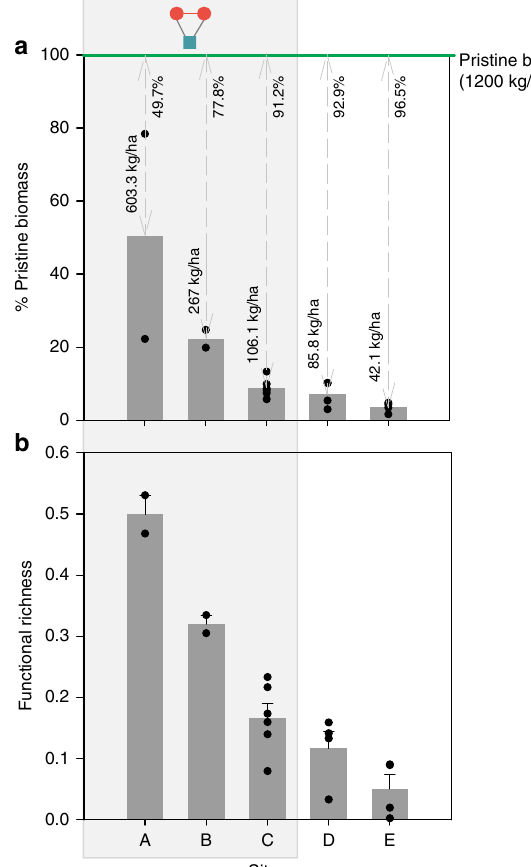
Fig. 4 Ecological conditions across study sites. Sites that have a signi fi cant, positive social – ecological network closure effect (sites A – C) are outlined in the gray box with the network icon. a Fish biomass observed in fi shed areas across each study site from underwater visual surveys compared to the expected level of pristine fi sh biomass (green line) for un fi shed reef ecosystems in Kenya, as reported by ref. 69 . Black dots are individual data points; gray bars and text above bars report mean biomass observed; gray arrows denote closeness toward pristine biomass (1200kg/ha); percentage difference between pristine and observed biomass is reported below the green line. b Functional richness of reef fi sh species (mean ± SE) in fi shed areas across each study site based on underwater visual surveys and a combination of abundances and trait values. Black dots are individual data points. There is a signi fi cantly higher mean level of both reef fi sh biomass and functional richness in sites with a positive tendency toward social – ecological network closure compared to those without [ t (9.49) = 2.09, p = .03; t (12.45) = 3.56, p < 0.01; respectively]; and effect size estimates suggest that these differences are meaningful (Cohen ’ s D =